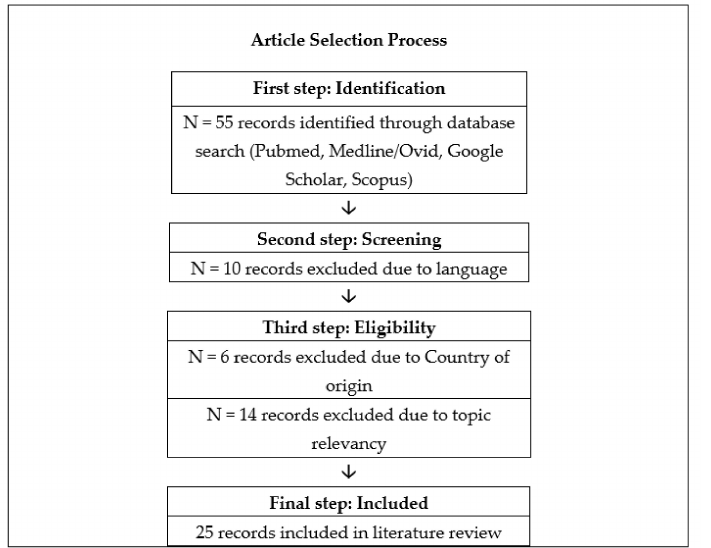
Figure 1. Diagram of the systematic literature review regarding migrants’ sexual violence in the Mediterranean